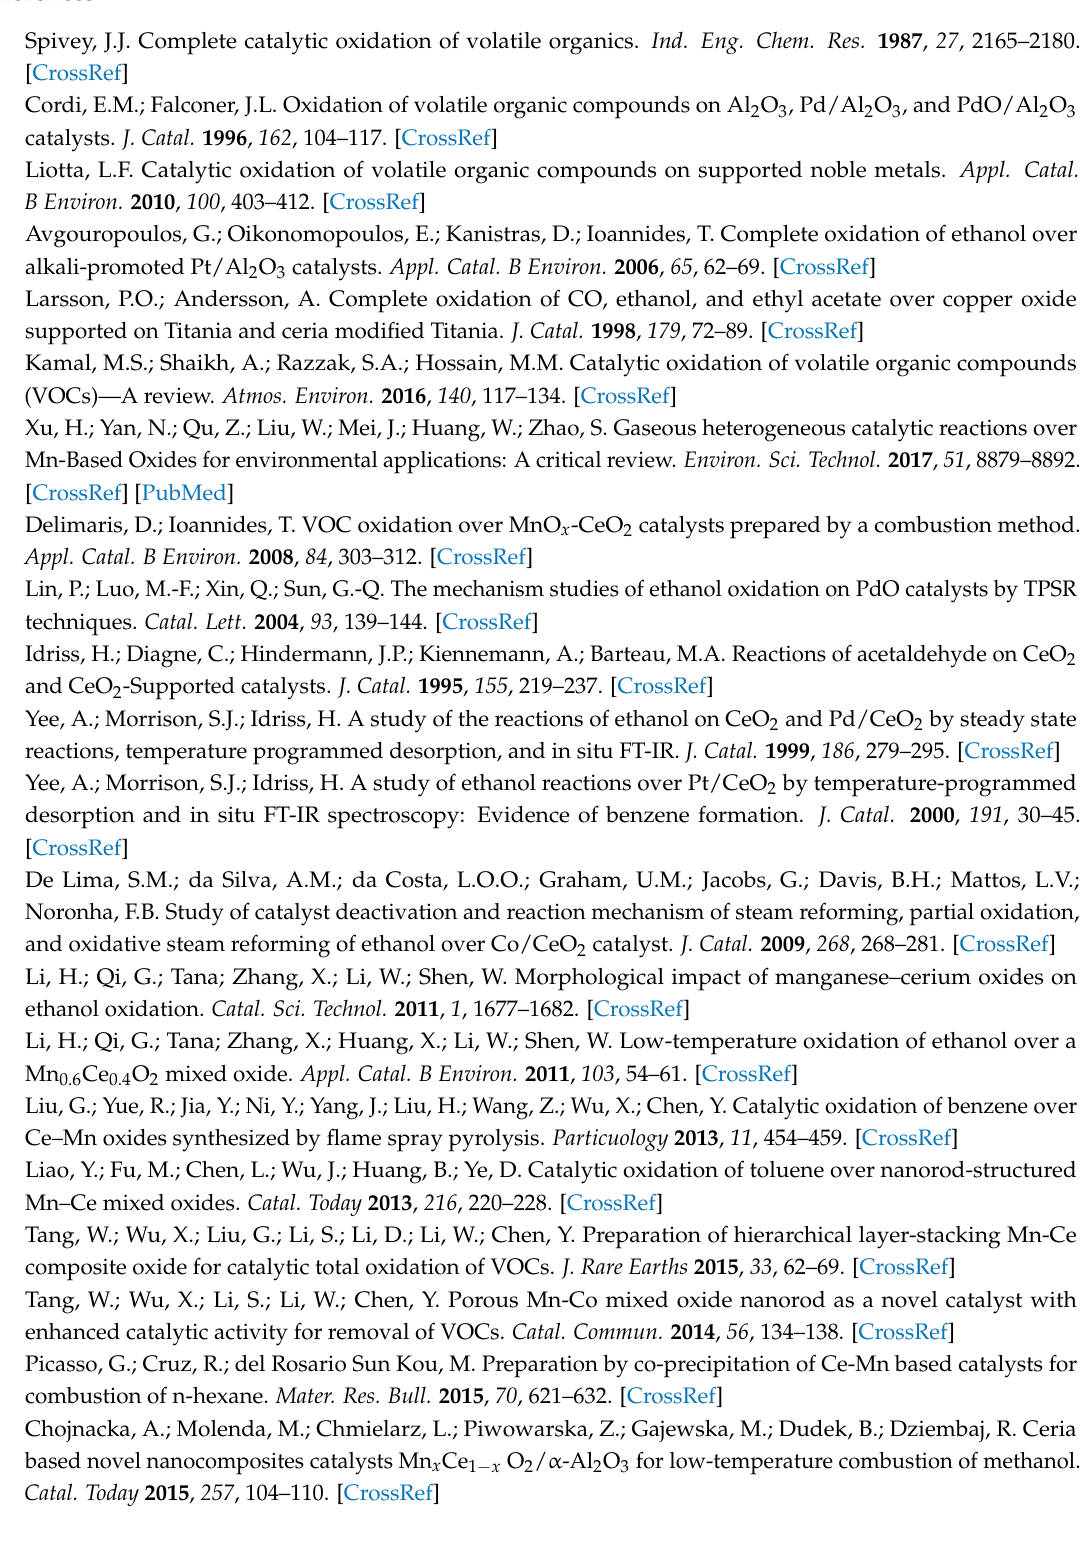
catalyst, Figure S5: TPO profiles following 12 CH 313 CH 2 OH adsorption on Mn 0.15 Ce 0.85 catalyst, Figure S6: TPO profiles following 12 CH 313 CH 2 OH adsorption on Mn 0.50 Ce 0.50